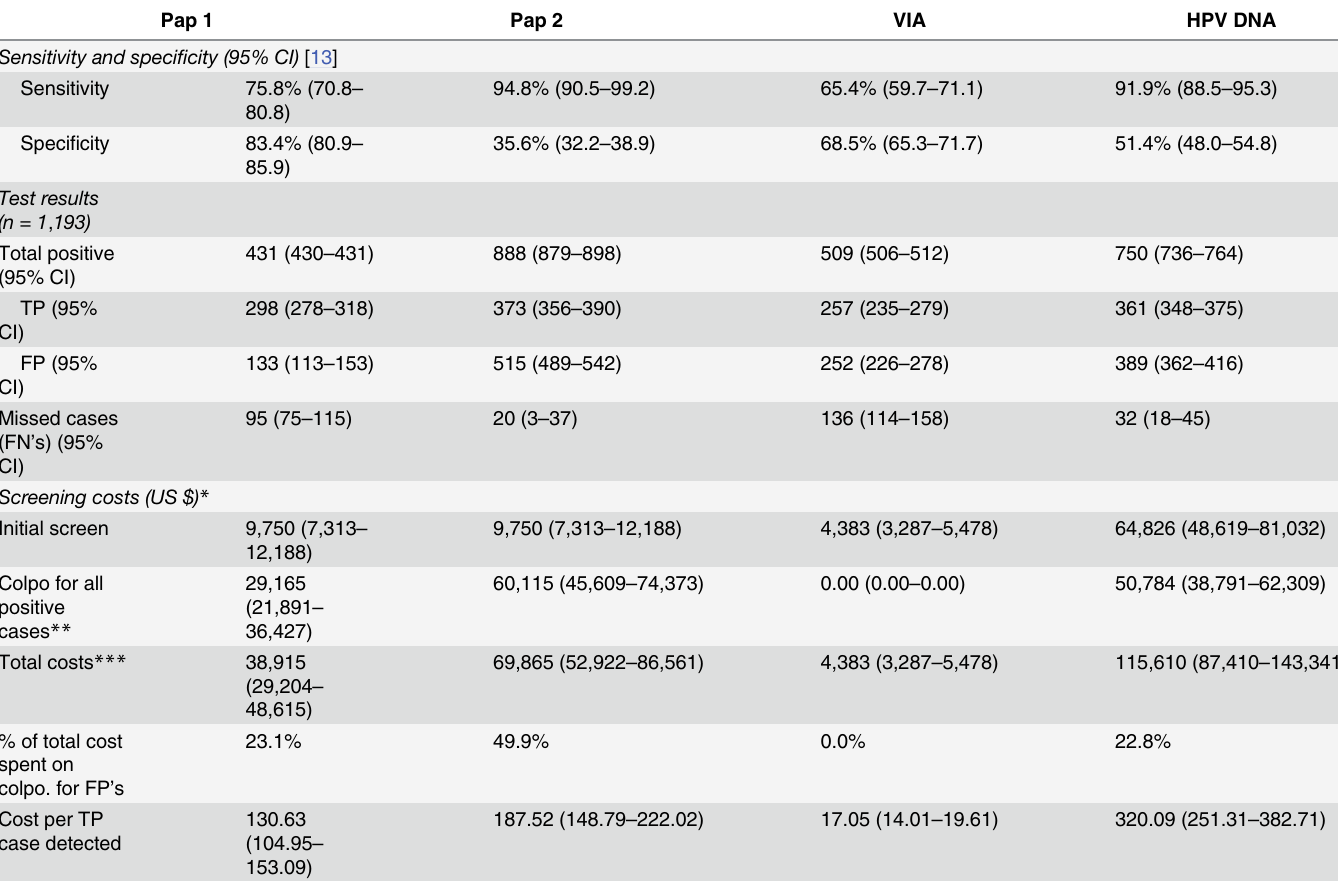
Table 4. Screening outcomes, costs for screening analytic cohort for CIN 2+ (Functional Limit scenario). Pap